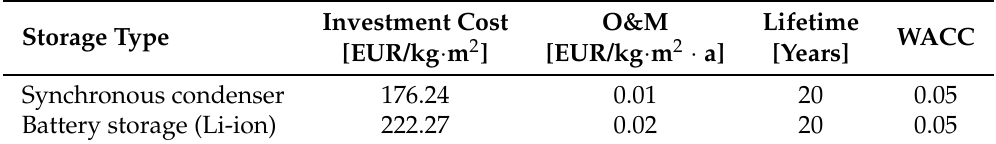
Table 4. Overview of investment parameters. Synchronous condenser parameters are derived by data from [42,43,59]. Li-ion battery storage parameters are derived by data from